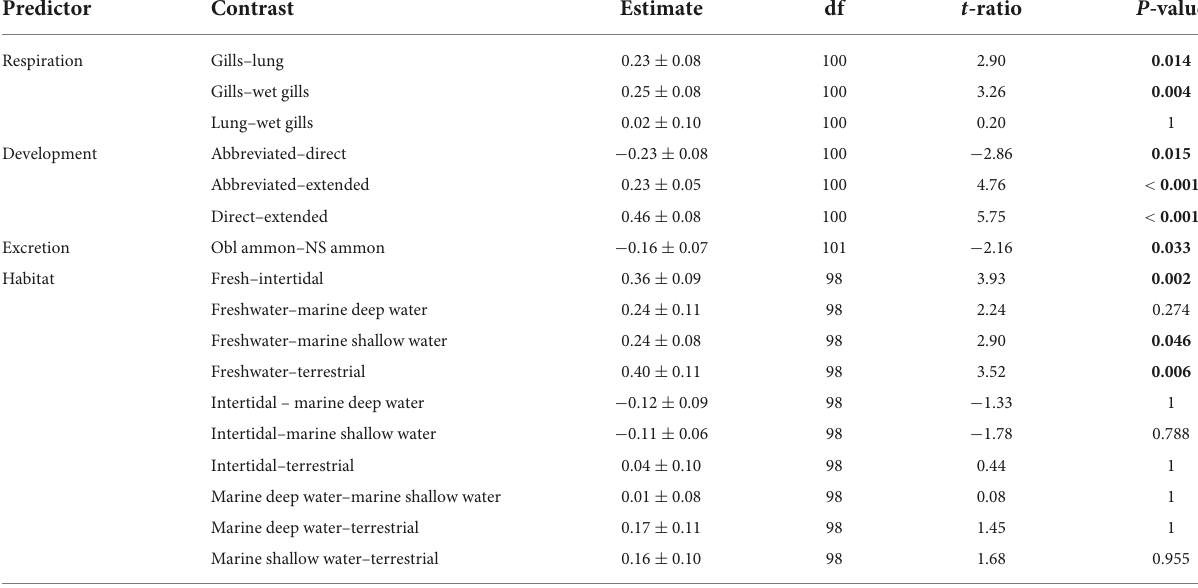
TABLE 6 Post hoc tests for the significant predictors included in the phylogenetic generalized least-squares (PGLS) models with the lowest (cid:49) AICc obtained for the subset comprising the species belonging to the infraorders Anomura, Astacidea, and Brachyura. Predictor